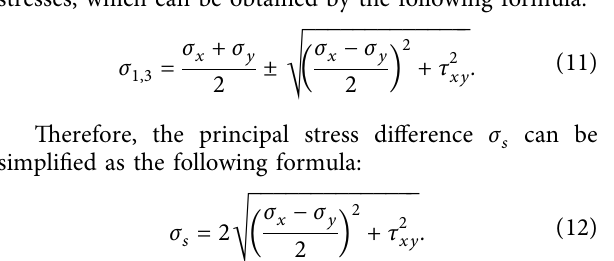
Figure 3: Distribution of the floor principal stress difference.